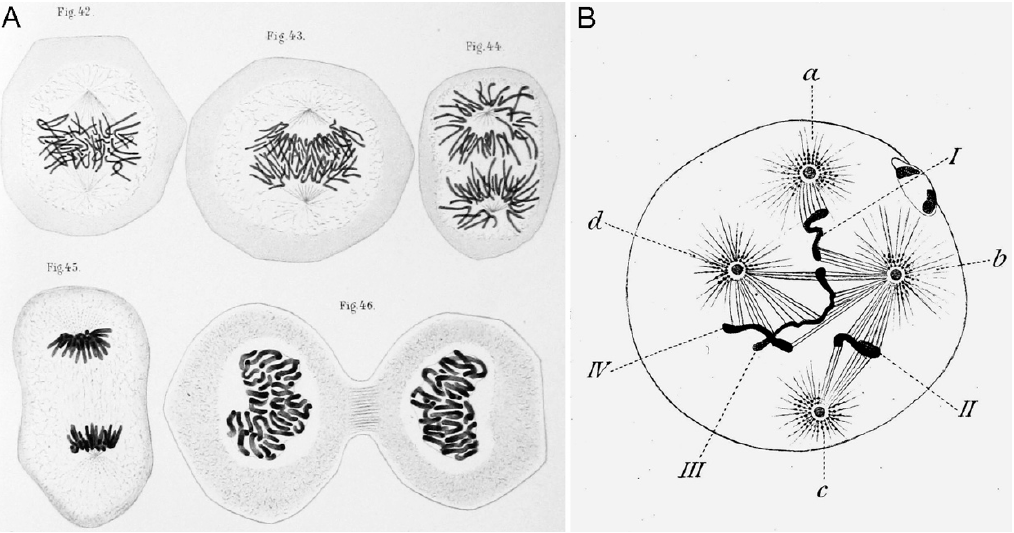
Figure 2. Historic drawings of mitotic figures. ( A ) Salamander peritoneal endothelial cells by Walther Flemming, 1882 [4]. ( B ) Fertilized Ascaris egg with multipolar spindles and unequal distribution of chromosomes by Theodor Boveri, 1888 [5]; public domain because of age.